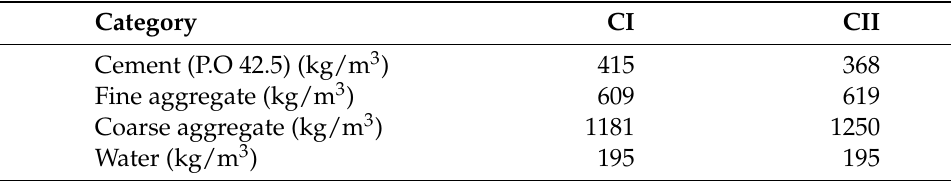
Table 1. Mixture proportions of the concrete specimen.